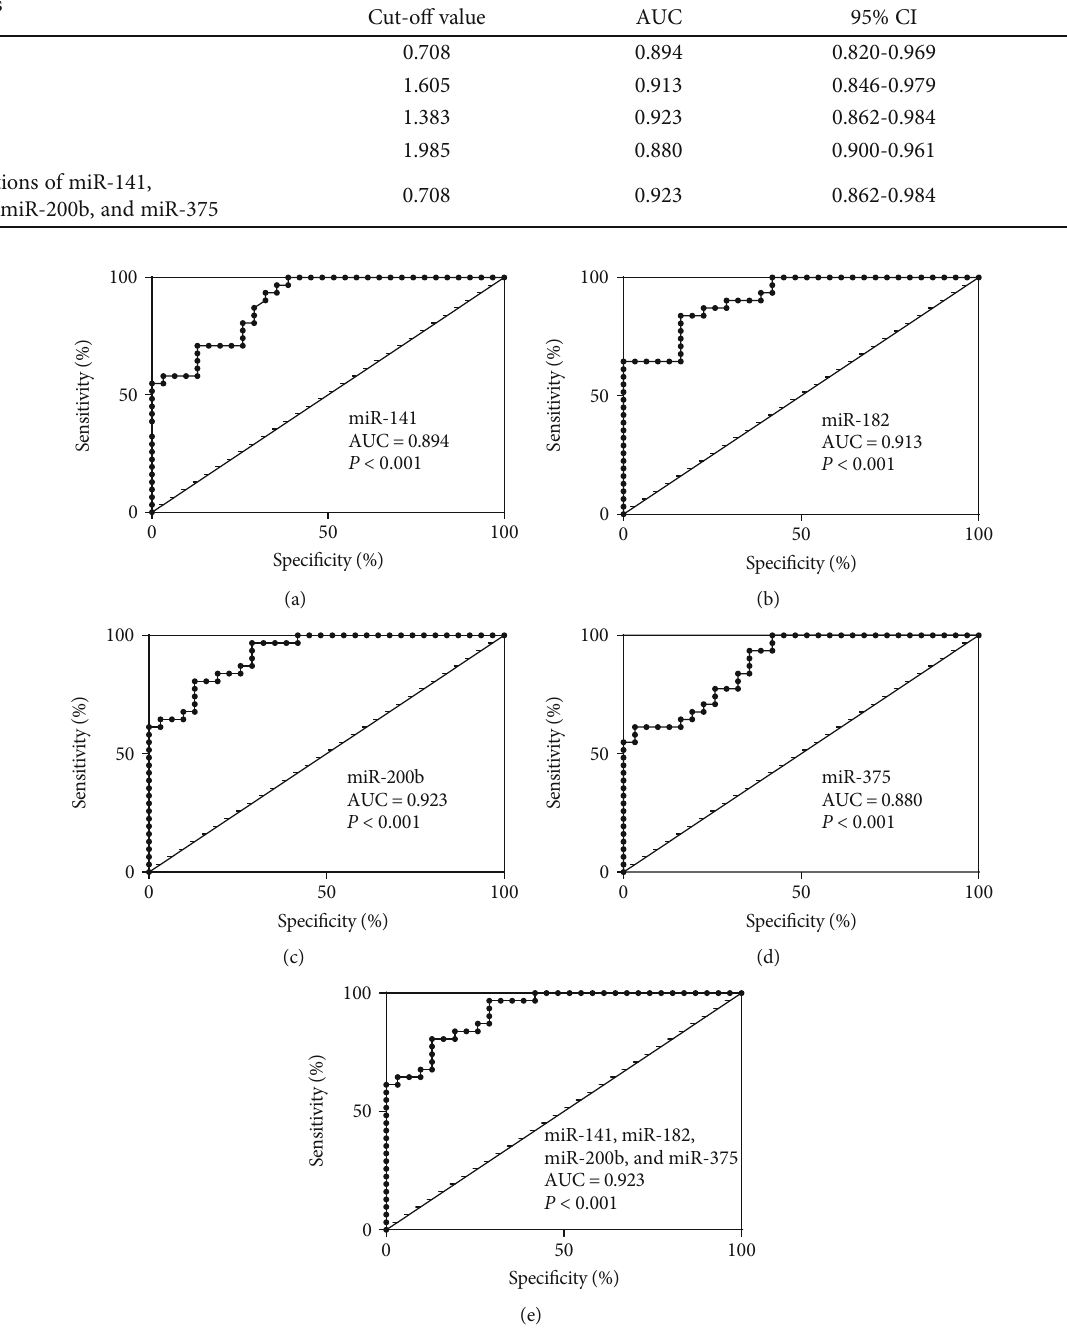
Figure 5: The ROC curve analysis of the miRNA levels in the PCa and BPH groups. (a) The ROC curve of miR-141, (b) the ROC curve of miR-182, (c) the ROC curve of miR-200b, (d) the ROC curve of miR-375, and (e) the combination of four miRNAs (miR-141, miR-182, miR- 200b, and miR-375) in the PCa and BPH